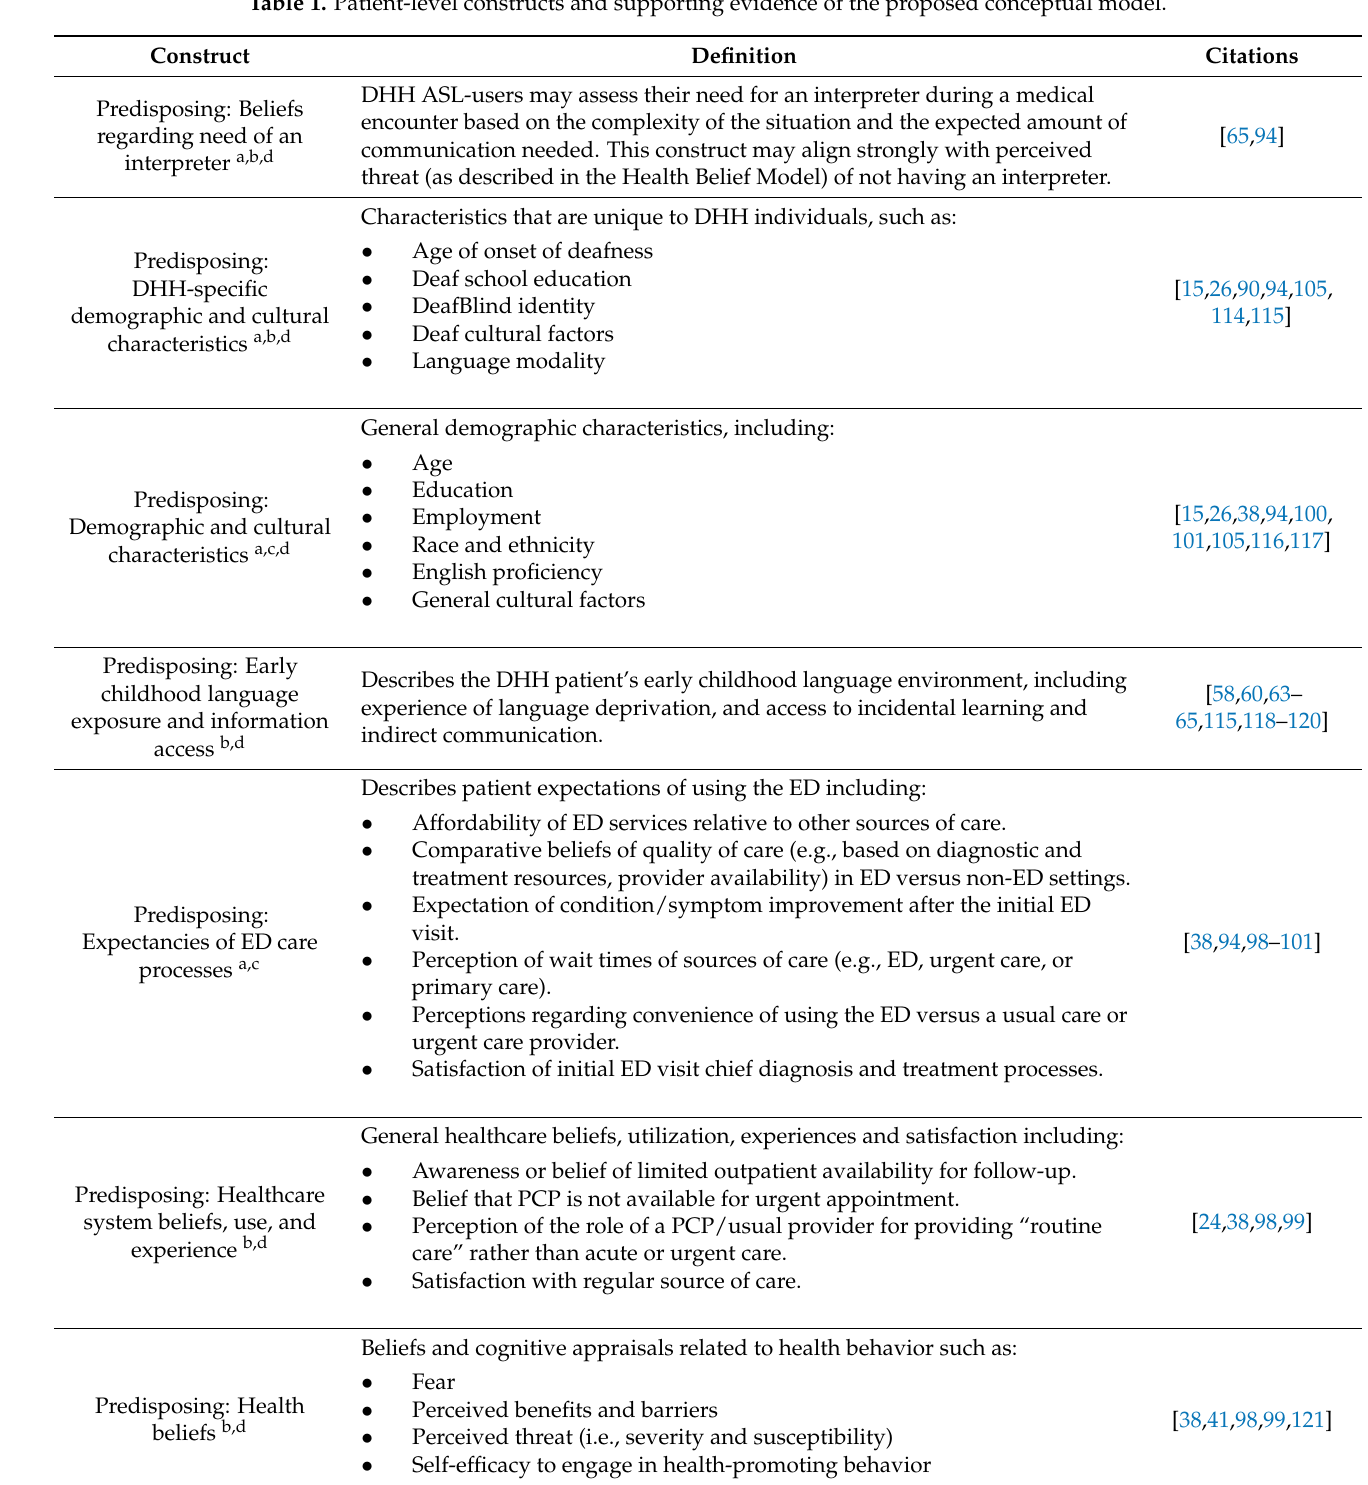
Table 1. Patient-level constructs and supporting evidence of the proposed conceptual